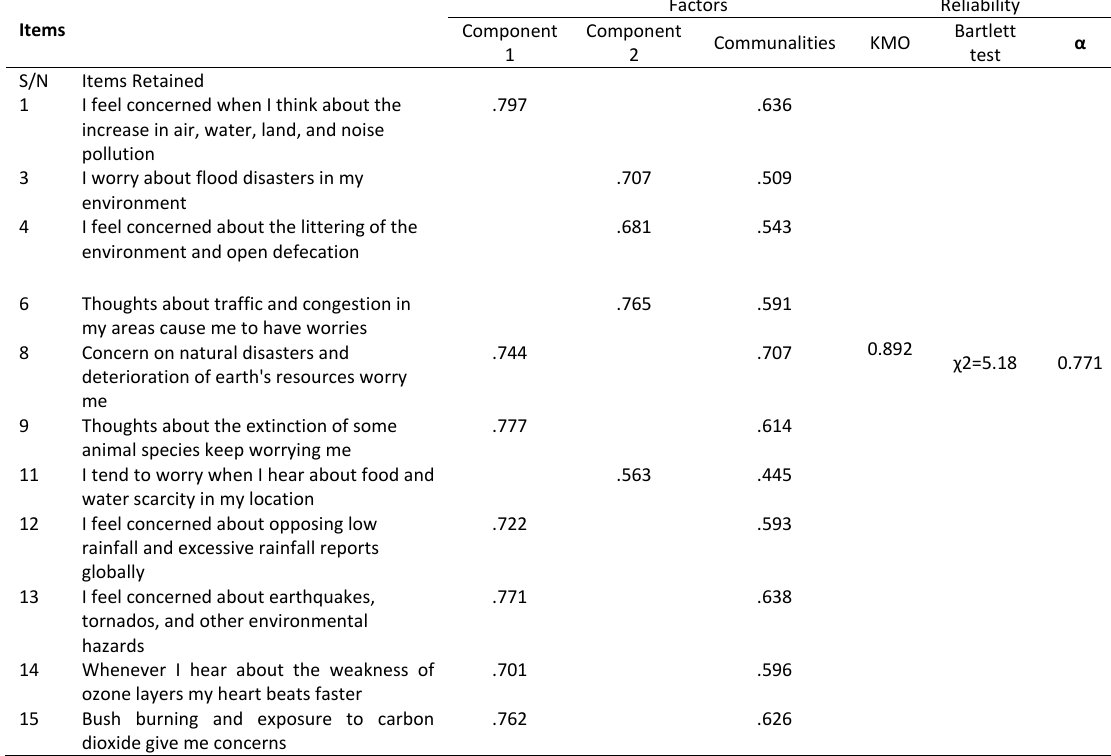
Table 1: Rotated Component Matrix with Principal Component Analysis as Extraction Method and Varimax Rotation with Kaiser Normalization and Reliability Coefficient for the new EWI Items S/N Items Retained